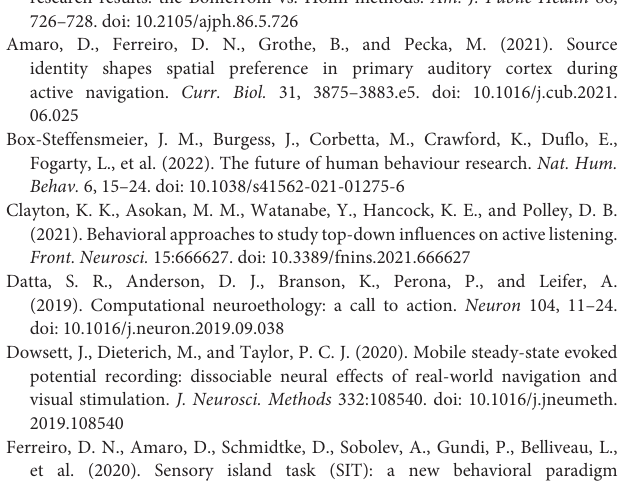
Supplementary Figure 4 | Fine-tuning behavior tends to correlate with discrimination performance when analyzing all trials (A) and when excluding coordinate trials (B) . Panels depict the correlation of fine-tuning proportion with normalized musical experience, median last frequency heard or standard deviation of the last frequency heard as a measure of the variability of the performance, respectively. Each dot represents a subject. All panels, y axis: proportion of gradient trials which showed fine tuning behavior. Pearson correlation coefficient and p-values are given in the